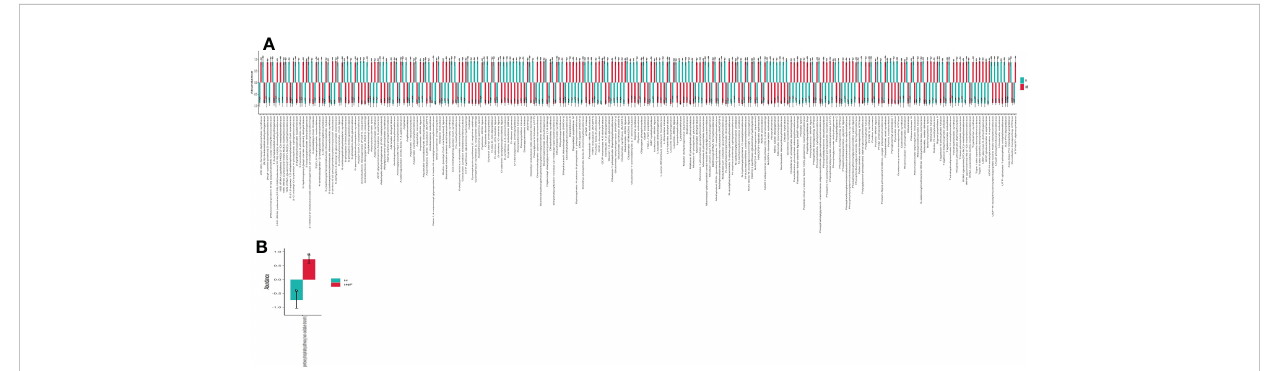
FIGURE 6 Cryptosporidium infection affected enzyme and MetaCys pathway abundance of yaks. (A) Enzyme ( p <0.001), (B) MetaCys ( p <0.05). "a, b" are showing signi fi cance